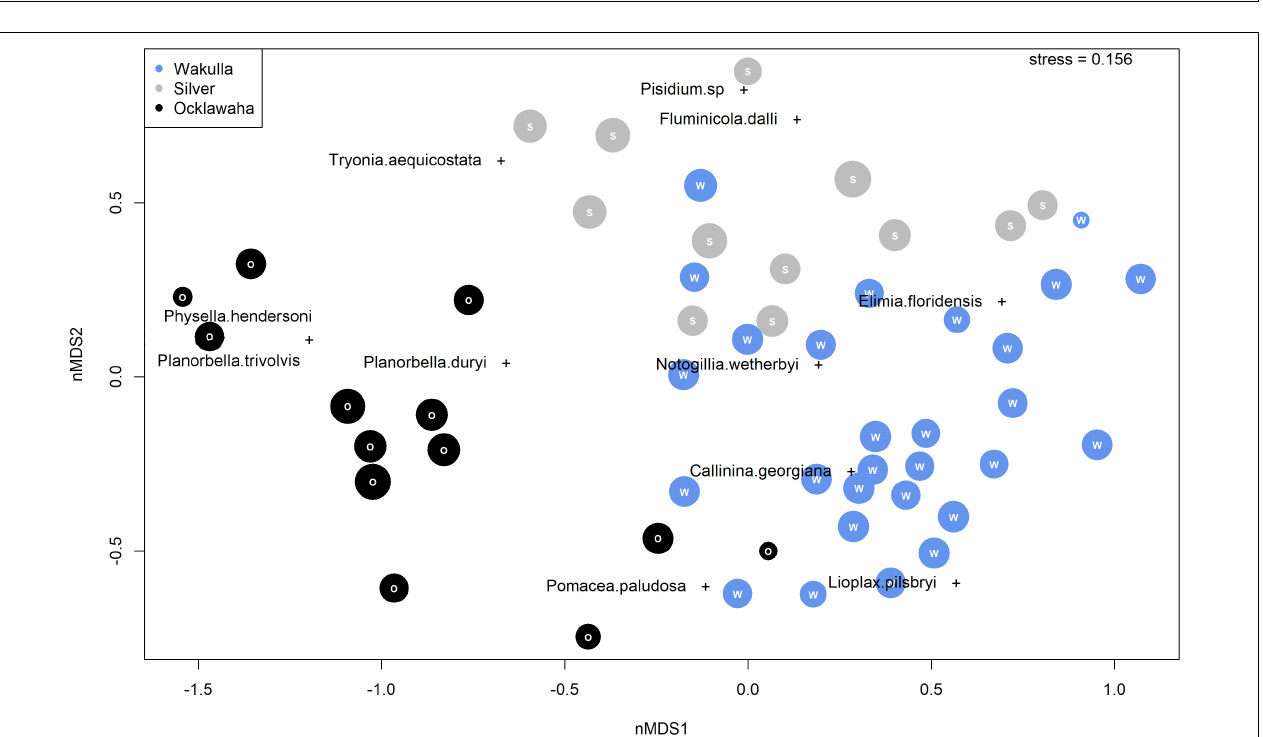
FIGURE 6 | Non-metric Multidimensional Scaling (nMDS) species and sample scores for fossil assemblages exclusively. Wakulla River samples in blue, Silver River samples in gray, and Ocklawaha River samples in black.